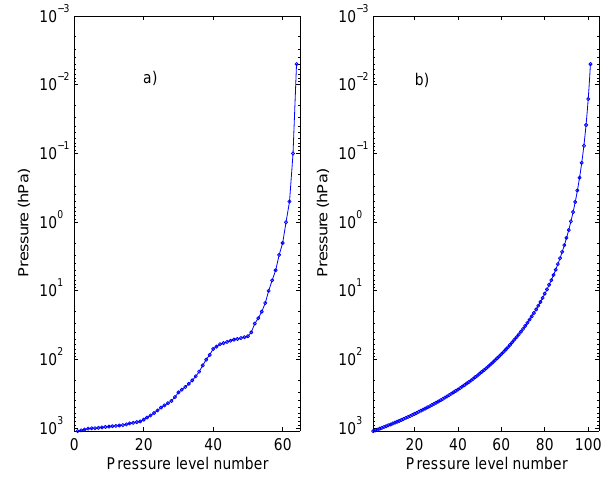
Fig. 4. The definition of the atmospheric pressure levels used in a) σ -IASI and b)